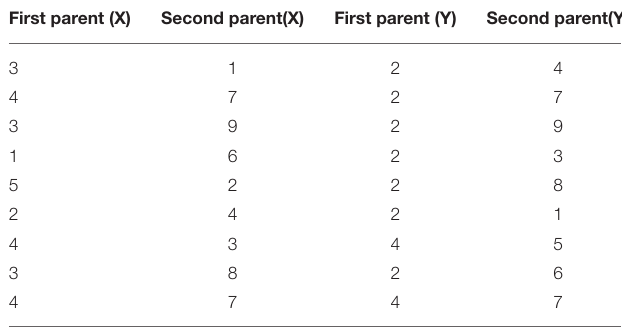
TABLE 3 | Values for the fourth generation-chromosomes in X and Y direction. Configurations ranking